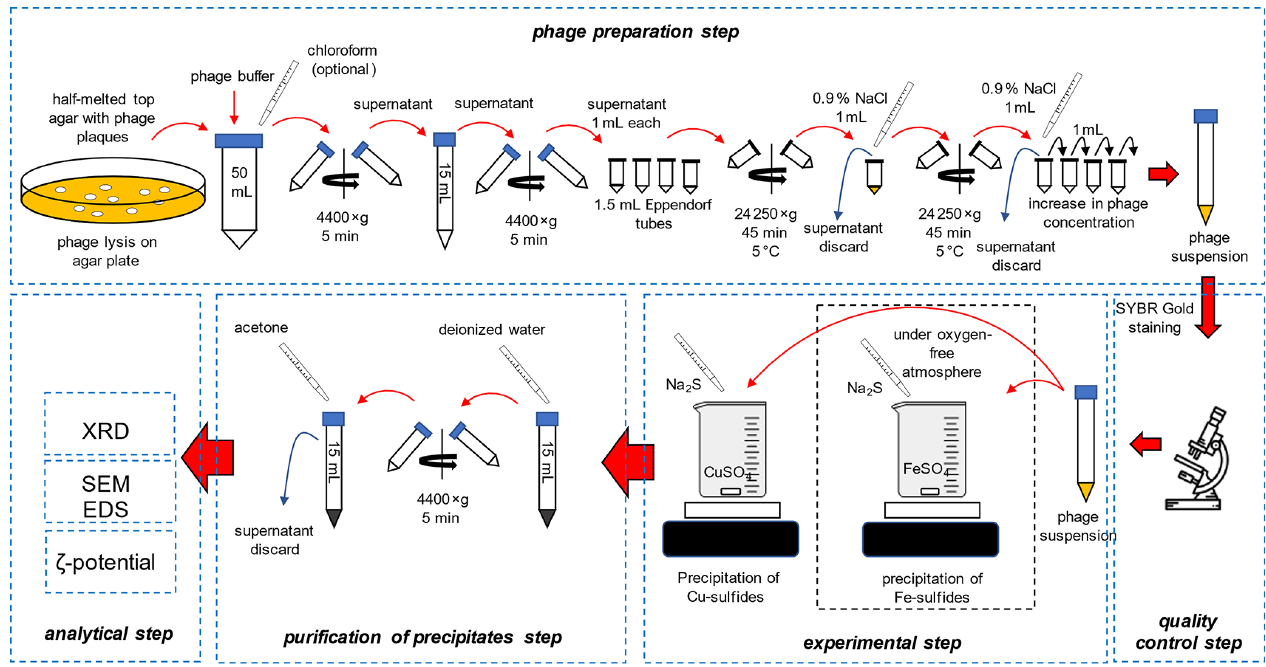
Figure 1. The scheme of experiments.